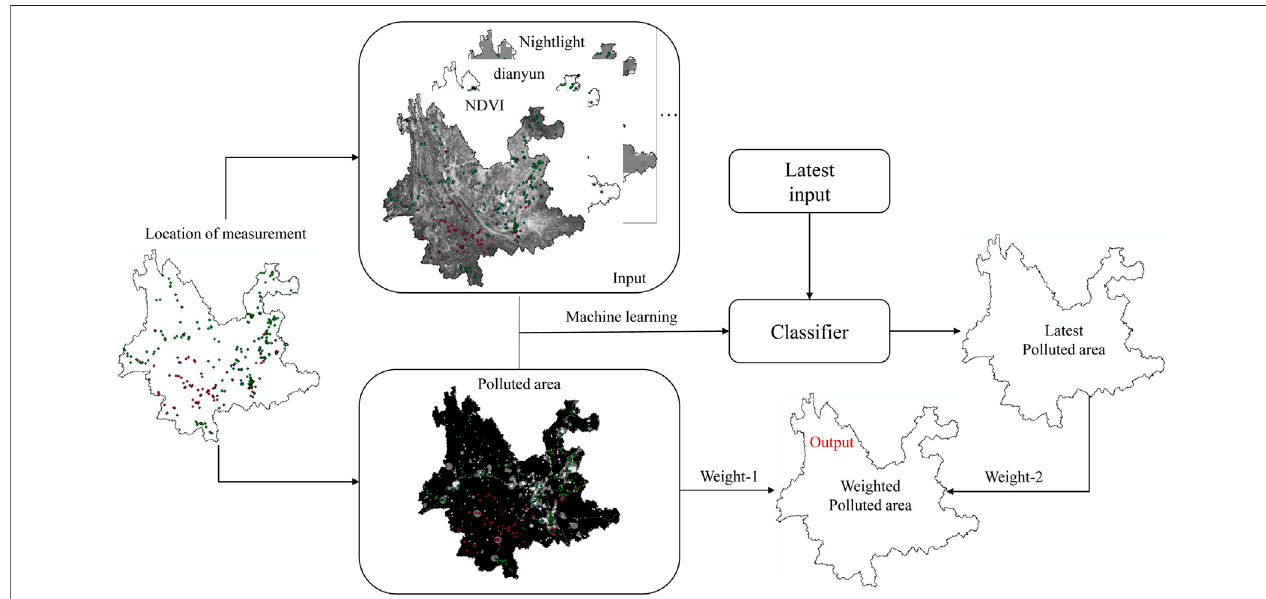
FIGURE 1 | Work fl ow diagram of the proposed framework for estimating the pollution distribution map (PDM).